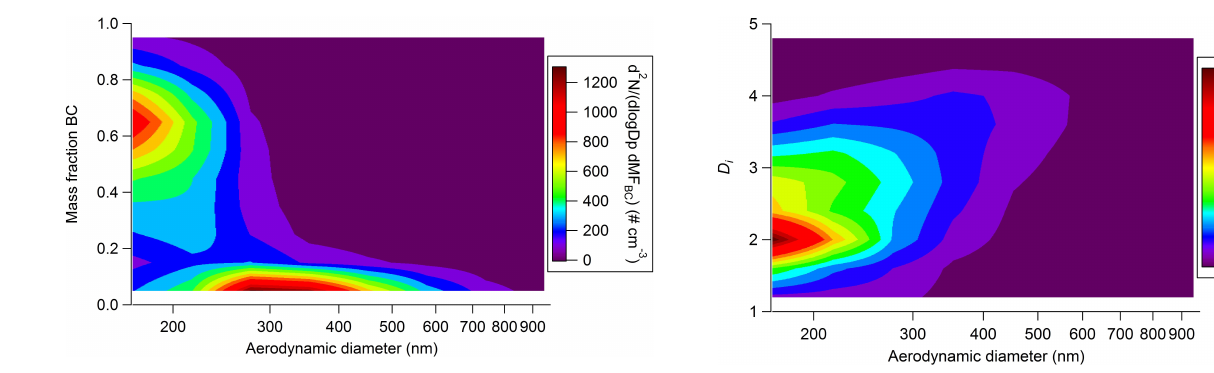
Figure 2. Campaign-averaged dependence of particle number con- centration on ATOFMS-derived single particle diversity ( D i ) and particle